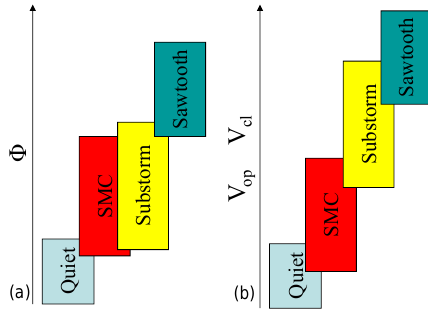
Figure 14. Different magnetospheric modes organized versus the open magnetic flux (cid:56) (left) and versus the opening and closure volt- ages V op and V cl